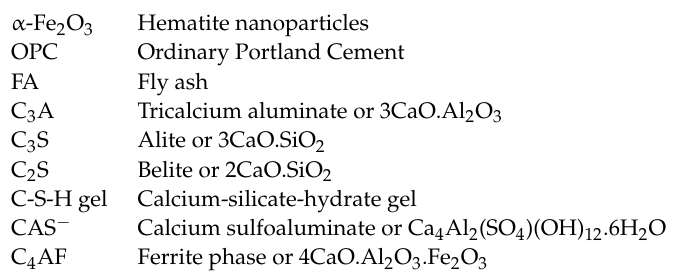
Figure S2. Syringe to fill water to the binder for hydration observation by TAM air calorimeter, Supplementary Figure S3. Mini-slump test operation, Supplementary Figure S4. Comparisons the heat flow and time of the hydration peak maximum for FA blended cement with commercial α -Fe 2 O 3 and synthesized α -Fe 2 O 3